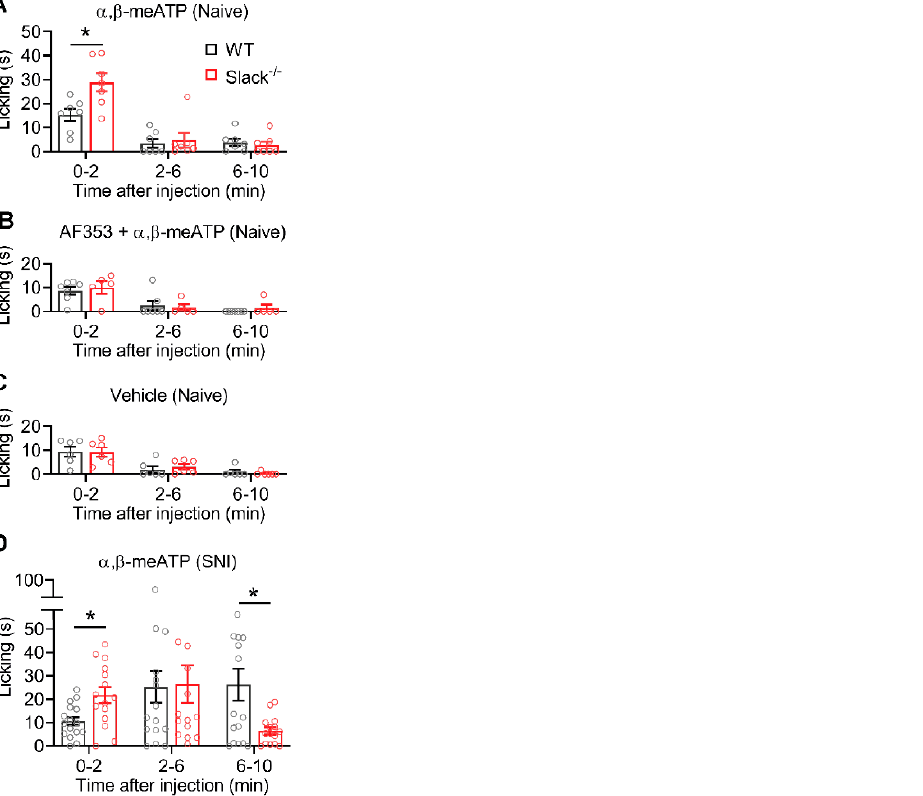
Figure 7. P2X3-dependent nocifensive behavior is altered in Slack -/- mice. Paw-licking responses induced by paw injection of drugs are shown. ( A ) The immediate paw licking in the first 2 min after injection of α , β -meATP (12 nmol) is increased in naive Slack -/- mice compared with WT mice ( n = 7/genotype; p = 0.0398 in 0–2 min; p = 0.9800 in 2–6 min; p = 0.9352 in 6–10 min). ( B ) No significant differences between groups occurred when the P2X3 receptor antagonist AF353 (70 nmol intraplantar) was injected 10 min prior to α , β -meATP ( n = 5–7/genotype; p = 0.9664 in 0–2 min; p = 0.9732 in 2–6 min; p = 0.7546 in 6–10 min). ( C ) Paw-licking responses after injection of the vehicle were comparable in Slack -/- and WT mice ( n = 6/genotype; p = 0.9999 in 0–2 min; p = 0.8934 in 2–6 min; p = 0.8709 in 6–10 min) and similar to the licking behavior after combined injection of α , β -meATP and AF353 ( B ). ( D ) When α , β -meATP (12 nmol) was injected in the ipsilateral hind paw after SNI, the paw-licking response persisted over the 10 min observation period in WT mice. In Slack -/- mice, the paw licking was increased in the first 2 min and decreased from 6–10 min compared with WT mice ( n = 16/genotype; p = 0.0262 in 0–2 min; p = 0.9993 in 2–6 min; and p = 0.0362 in 6–10 min). Two-way ANOVA tests were performed. Bars denote mean ± SEM. * p ˂ 0.05.